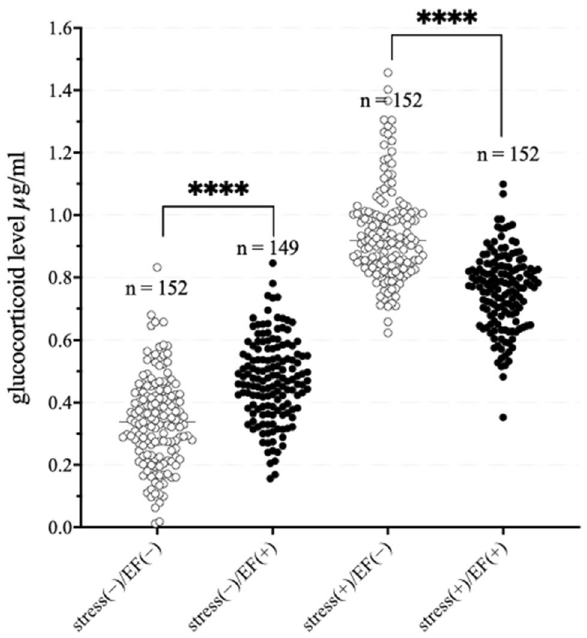
Figure 1. Effect of immobilisation and electric field exposure on immobilisation-induced increase in the plasma glucocorticoid level. Data of 19 tests conducted from 2015 to 2019 (number of tests: 14–32, n = 149–152) were pooled.